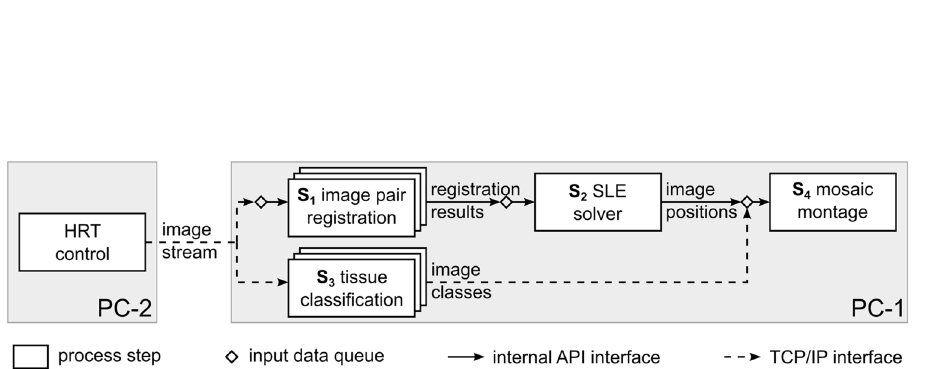
Figure 2. Schematic illustration of the CCM setup with focus plane control and guided eye movements (modified from 20 ).